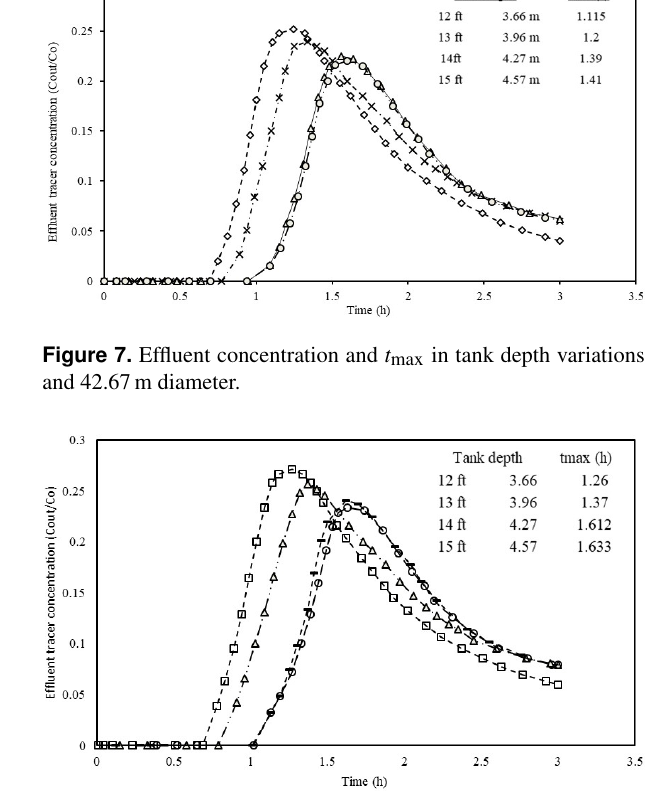
Figure 8. Effluent concentration and t max in tank depth variations and 51.82m